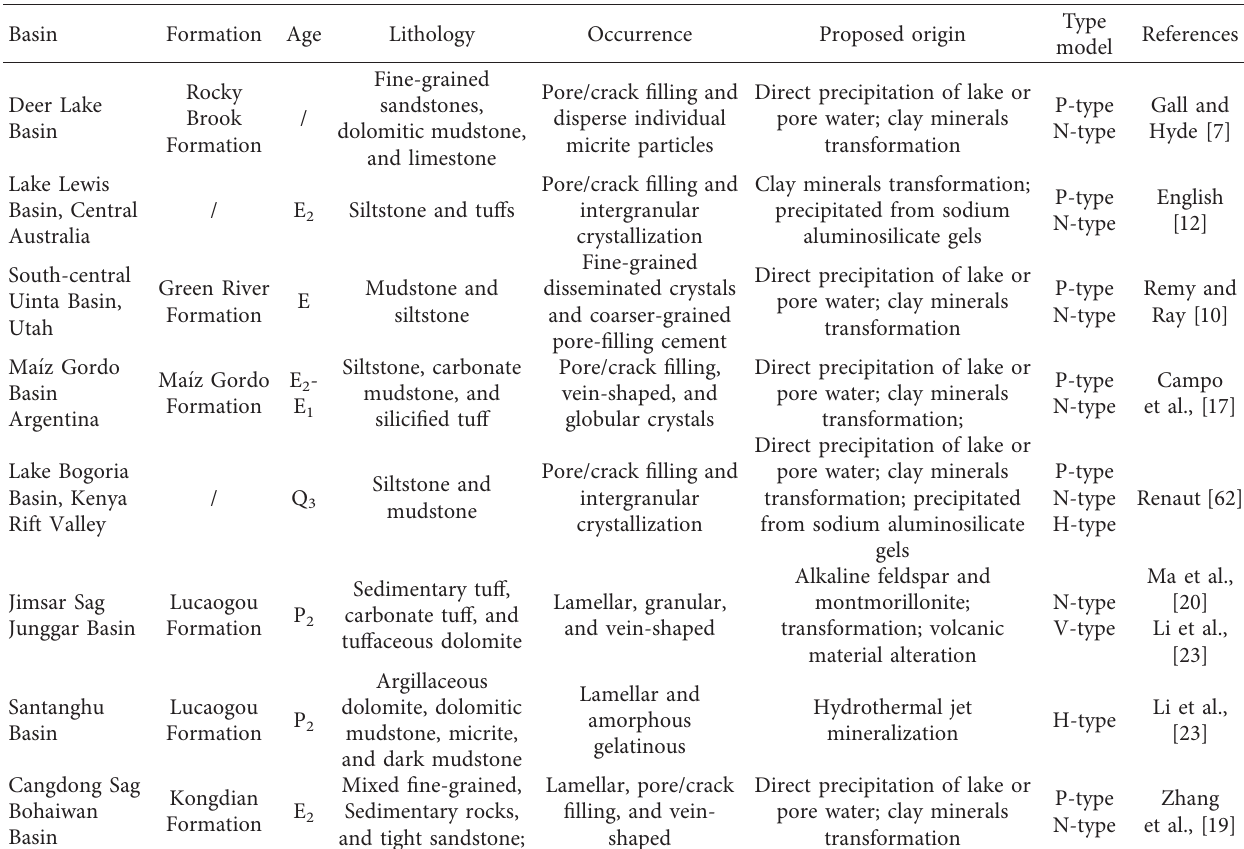
Table 2: Analcime in lacustrine fine-grained sedimentary